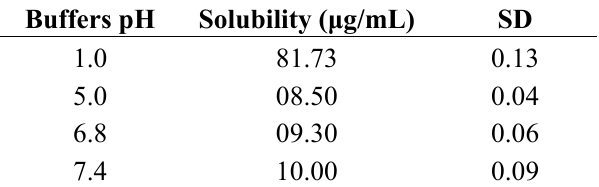
Table 1. Solubility of NCE in phosphate buffers ( n = 3, mean).